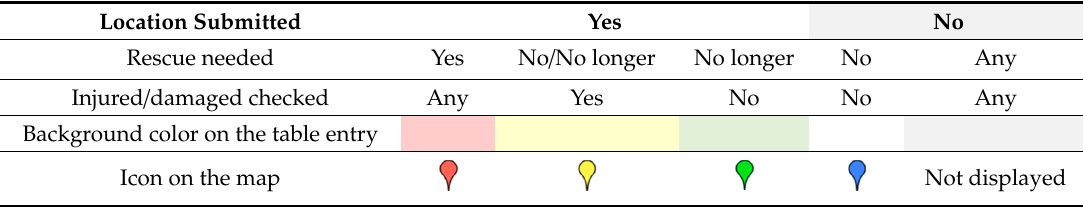
Icon on the map